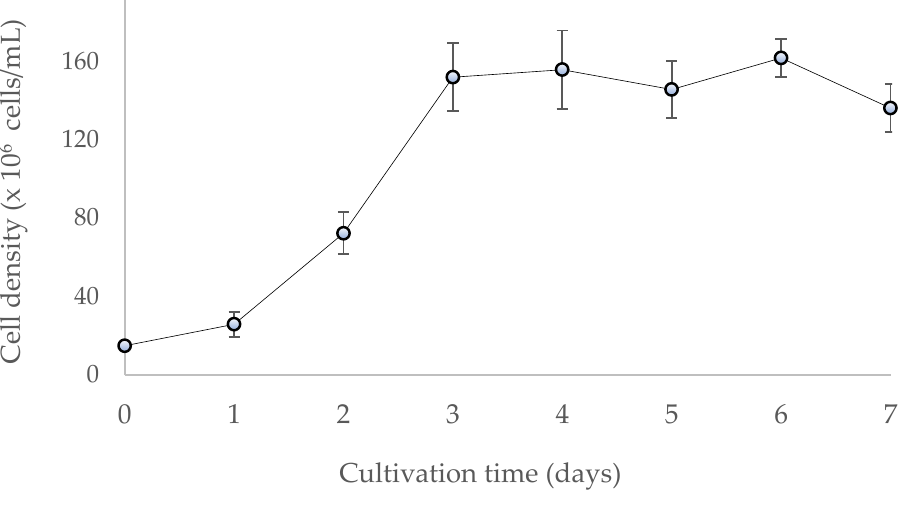
Figure 1. Growth curve of the microalgae C. muelleri .